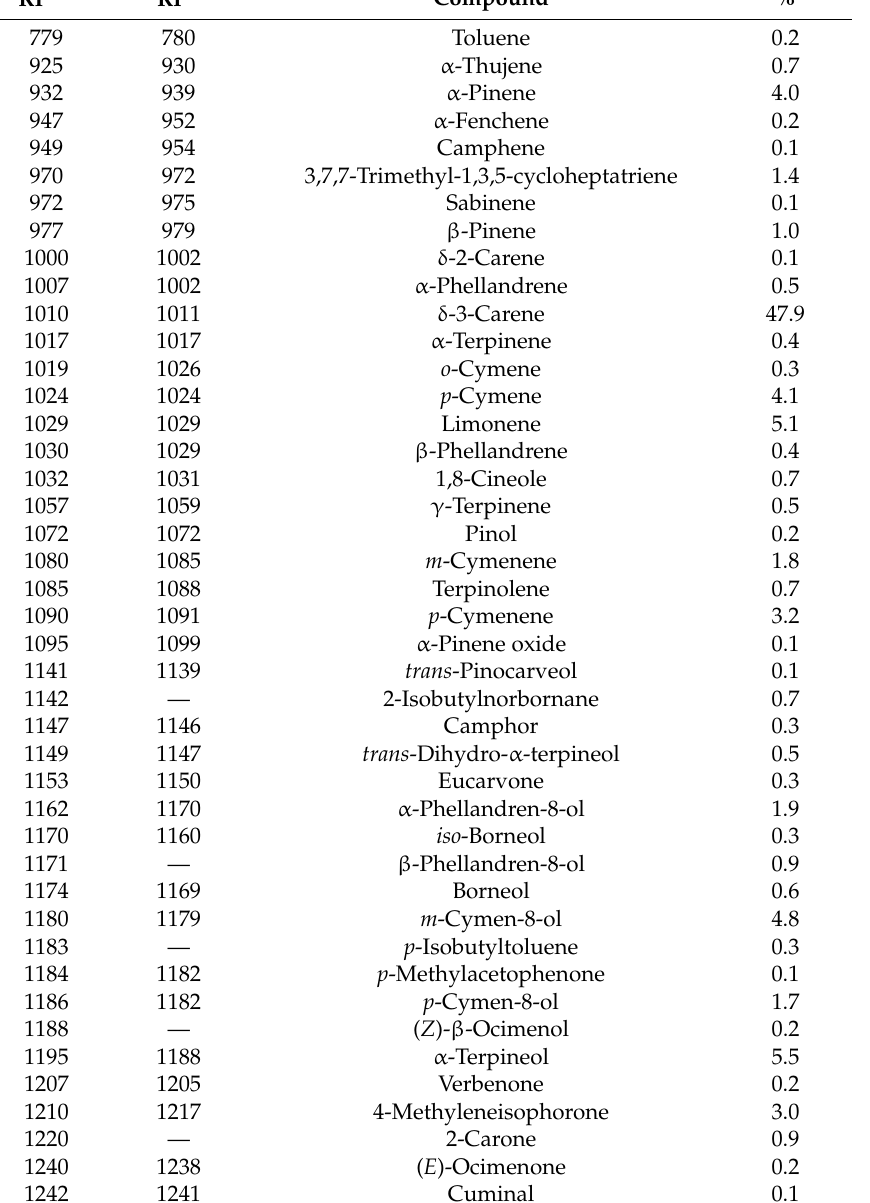
Table 2. Chemical composition of the oleoresin essential oil of Protium amazonicum from Ecuador. RI calc RI lit Compound % 780